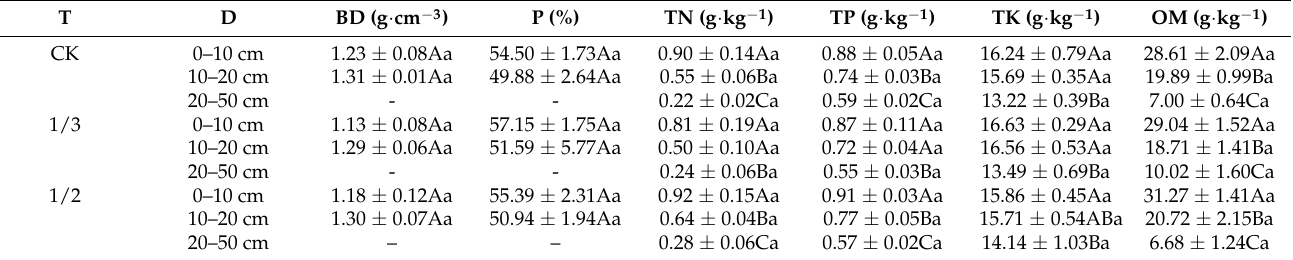
Table 2. Soil physicochemical properties (mean ± standard error) of the poplar plantation before